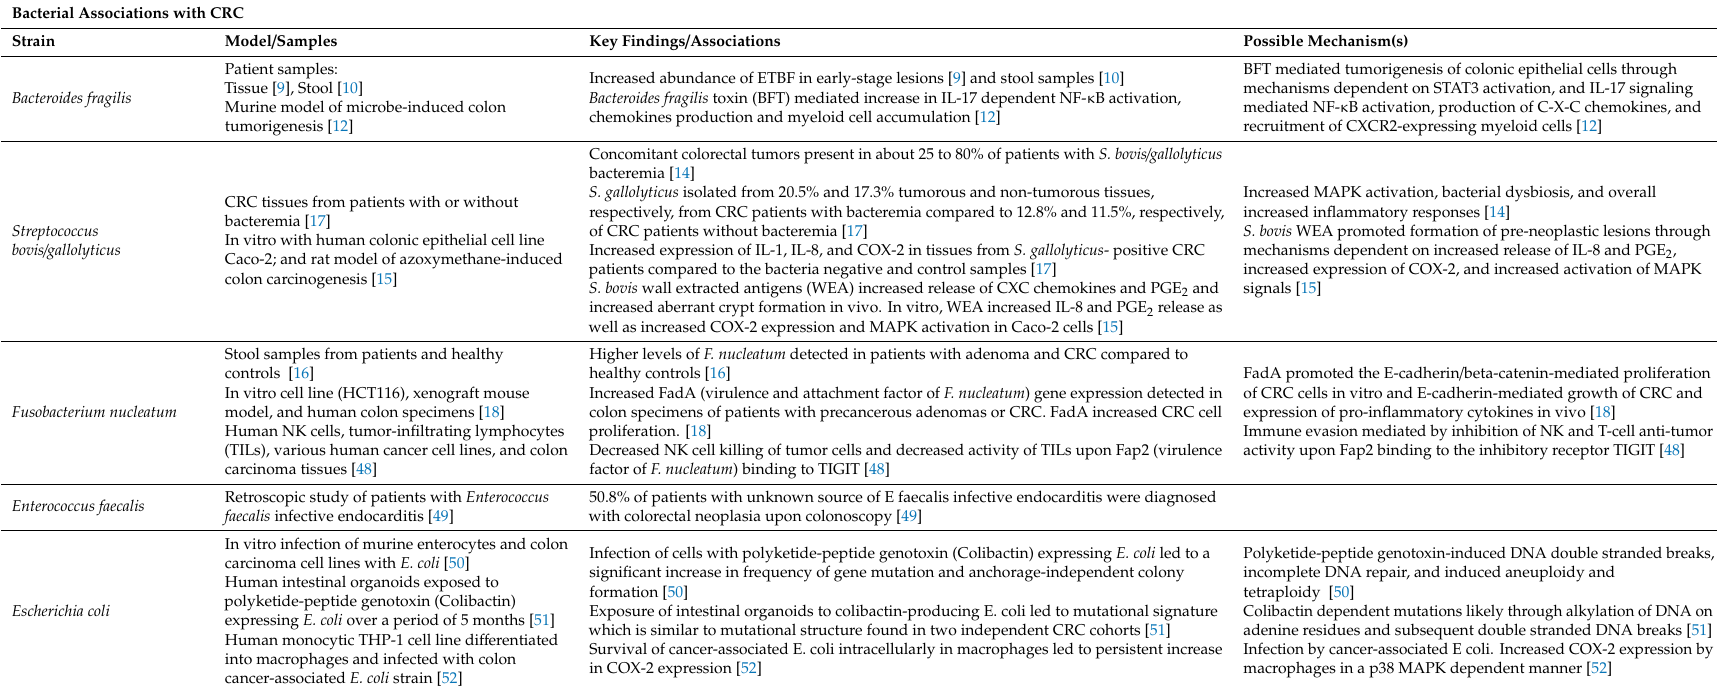
Table 1. Summary of bacterial associations with colorectal cancer (CRC) or promotion of